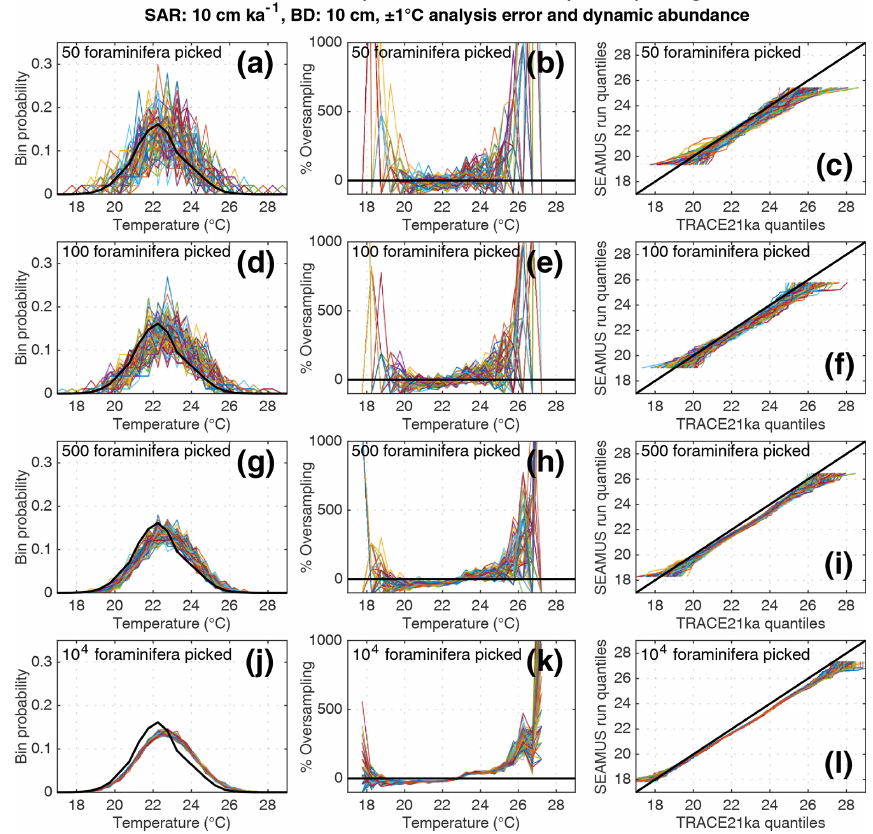
Figure 8. Simulated single foraminifera SST distributions from 100 ensembles of SEAMUS runs, with SAR of 10cmkyr − 1 , BD of 10cm, ± 1 ◦ C analytical error and dynamic abundance (following Fig. 2a). In each ensemble, the single foraminifera SST distribution from a single discrete depth with a simulated median age of 17.5ka is compared to the TRACE-21ka SST distribution for the 18 to 17ka period. The left panels (a, d, g, j) show the 100 SEAMUS ensembles as coloured lines in the case of 50, 100, 500 and 10 4 randomly picked foraminifera, with the TRACE-21ka SST distribution shown as a black line. The middle panels (b, e, h, k) show the rate of oversampling/undersampling for each of the 100 SEAMUS ensembles (coloured lines) relative to the TRACE-21ka SST distribution (black line) in the case of 50, 100, 500 and 10 4 randomly picked foraminifera. The right panels (c, f, i, l) show Q–Q plots of the 100 SEAMUS ensemble quantiles vs the TRACE- 21ka quantiles as coloured lines in the case of 50, 100, 500 and 10 4 randomly picked foraminifera, with a perfect 1:1 correspondence to TRACE-21ka shown for reference as a black